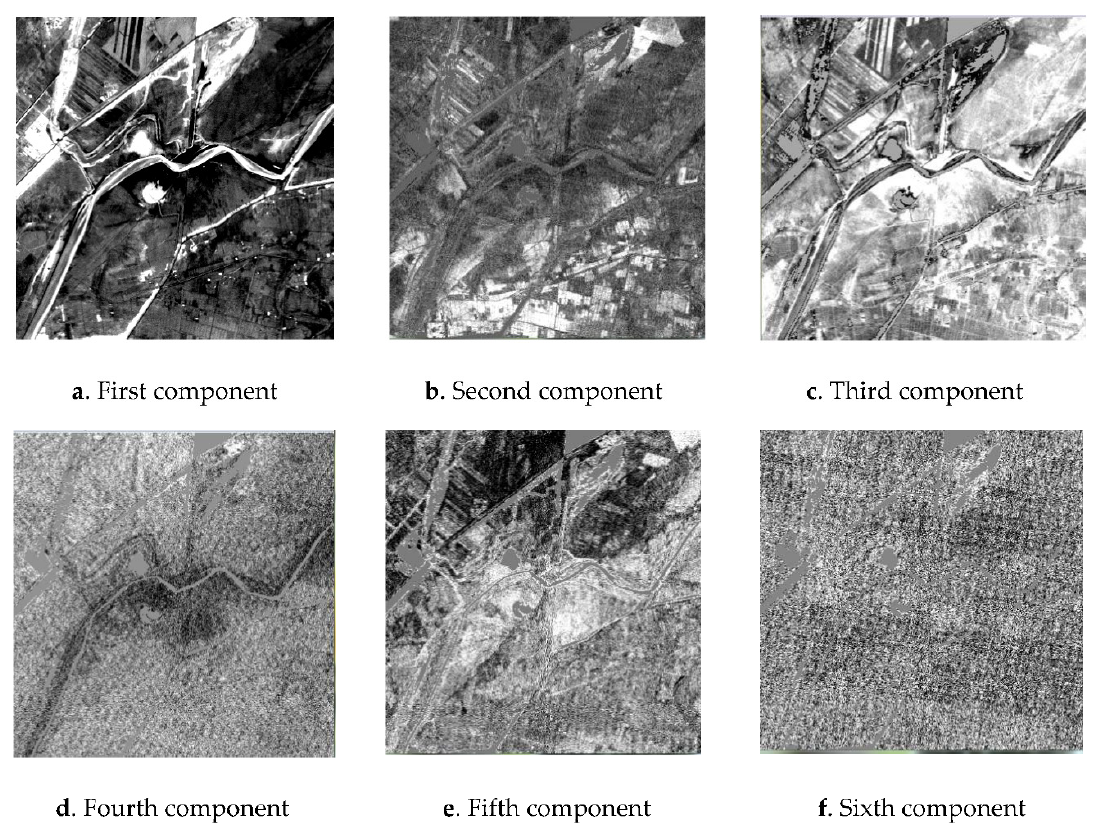
Figure 5. Six components of Minimum Noise Fraction (MNF) images derived for the same area of Dongying City.